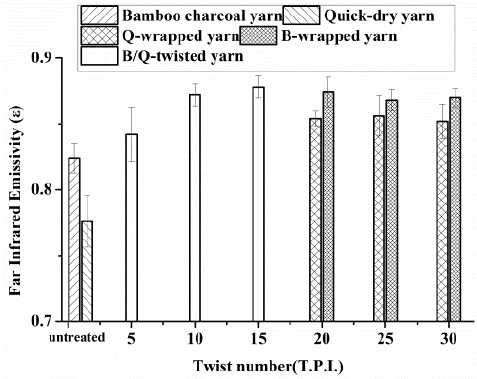
Figure 14. Far infrared ray (FIR) emissivity of functional elastic knits in relation to the administration of a wrapping/twisting process, as well as the twist number of the yarns. The error bar indicates the SD. In comparison of the control group (i.e., elastic knits that were composed of bamboo charcoal yarn), the experimental groups (i.e., functional elastic knits that were composed of Q-wrapped